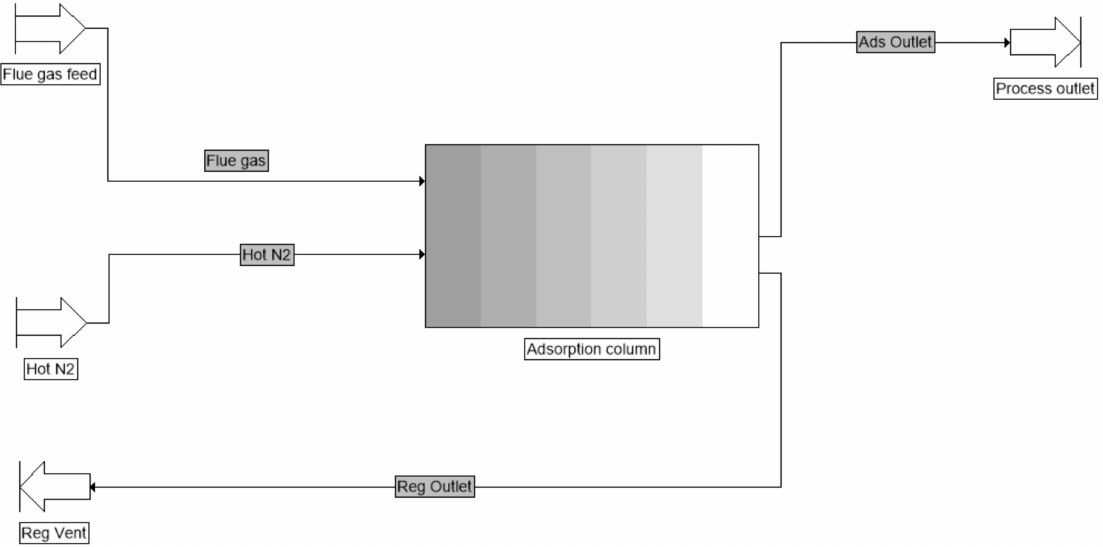
Figure 7. Process flow-chart built in the ProSim DAC simulation software.